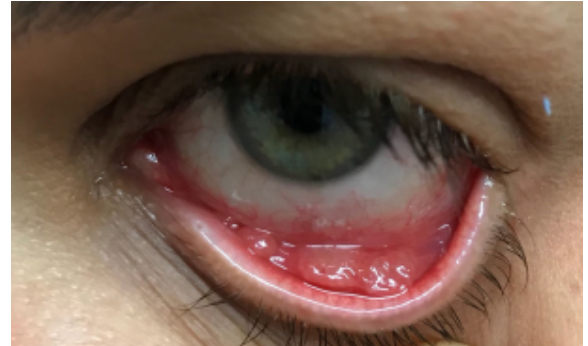
Figure 1: Granulomatous lesion on the lower eyelid of the left eye